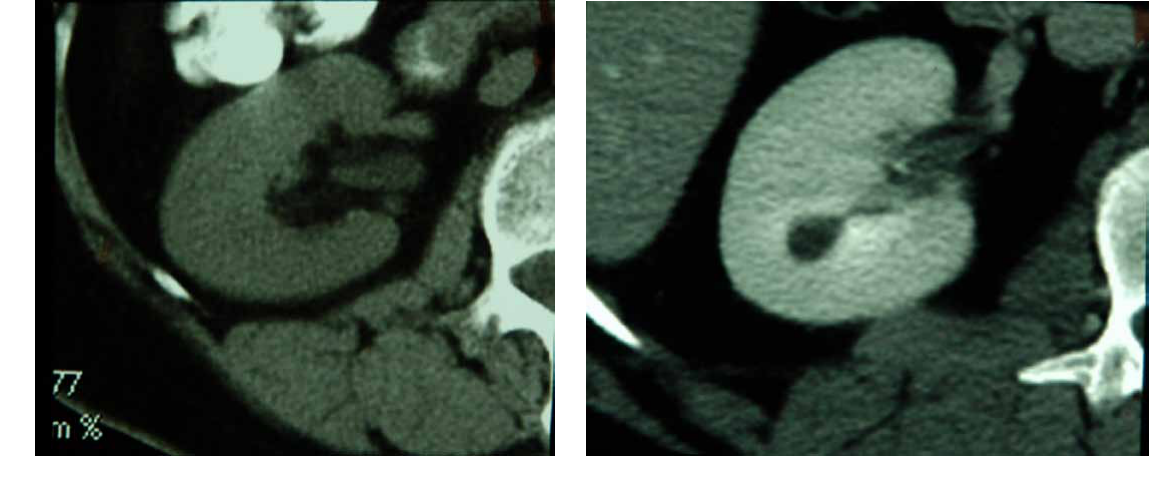
Figure 2 – On pre-enhancement CT(left) one can not identify a parenchymal lesion. However, the parenchymal phase CT(right) shows a non-enhancing mass in the right medullary pyramid. The finding of a mass identifiable only on post-enhancement phases, but isodense on pre-enhancement phase, is pathognomonic for renal medullary necrosis